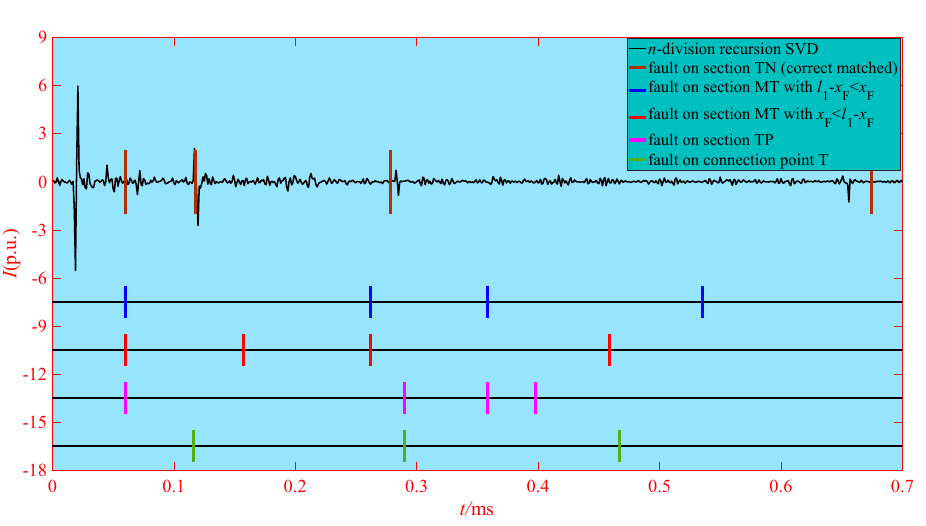
Figure 18. Full-line matching algorithm for section l 1 fault and matching results with n -division recursion SVD.